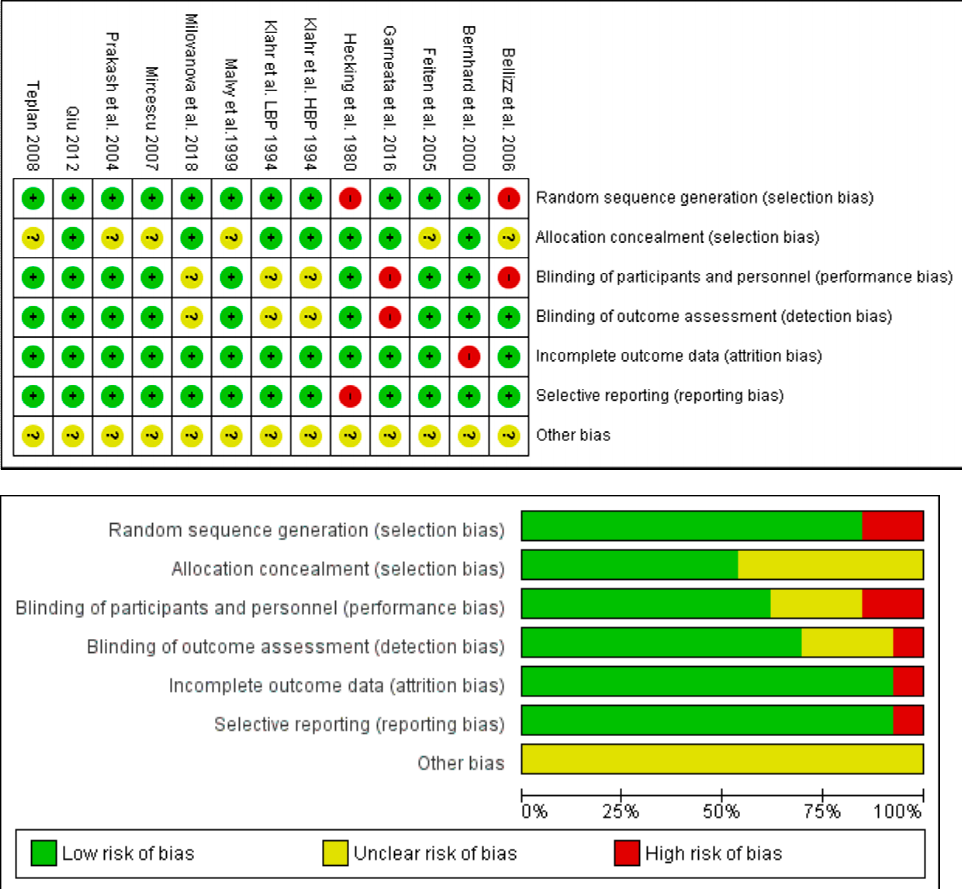
Figure 13. Assessment of the risk-of-bias of the studies included in this meta-analysis. Upper panel: summary of the risk-of-bias. Lower panel: graph of the risk of bias.